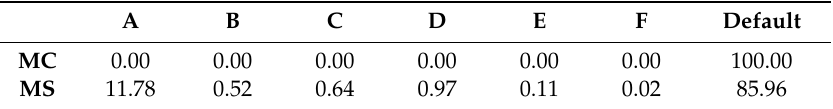
attracted in the default state. In the case of the MS model, we observe that stayer companies remain stable within their rating